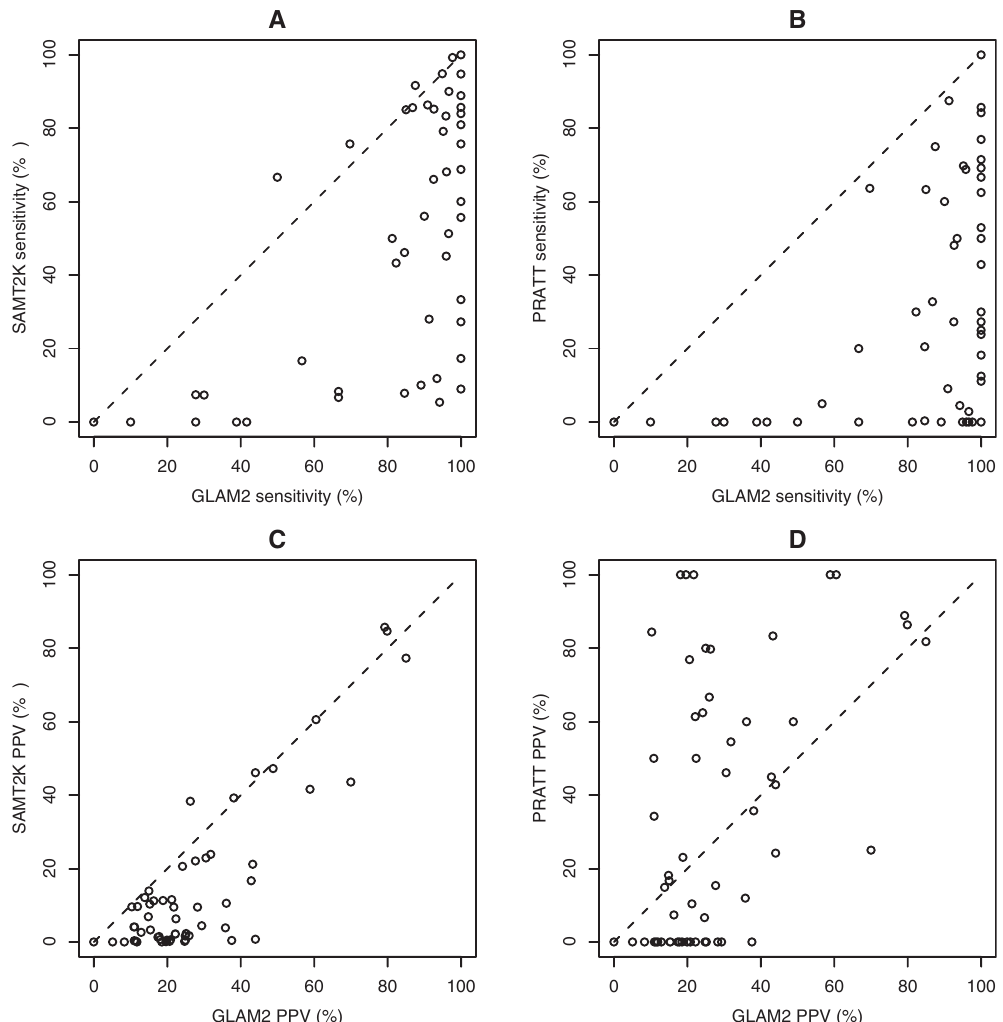
Figure 2. Sensitivity and positive predictive value of GLAM 2 compared to SAM - T 2 K and PRATT on 58 PROSITE motifs.